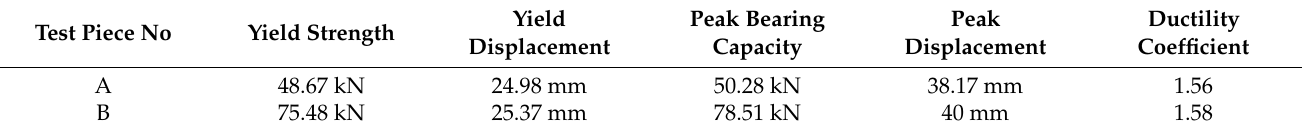
Table 4. Performance turning point of skeleton curve.